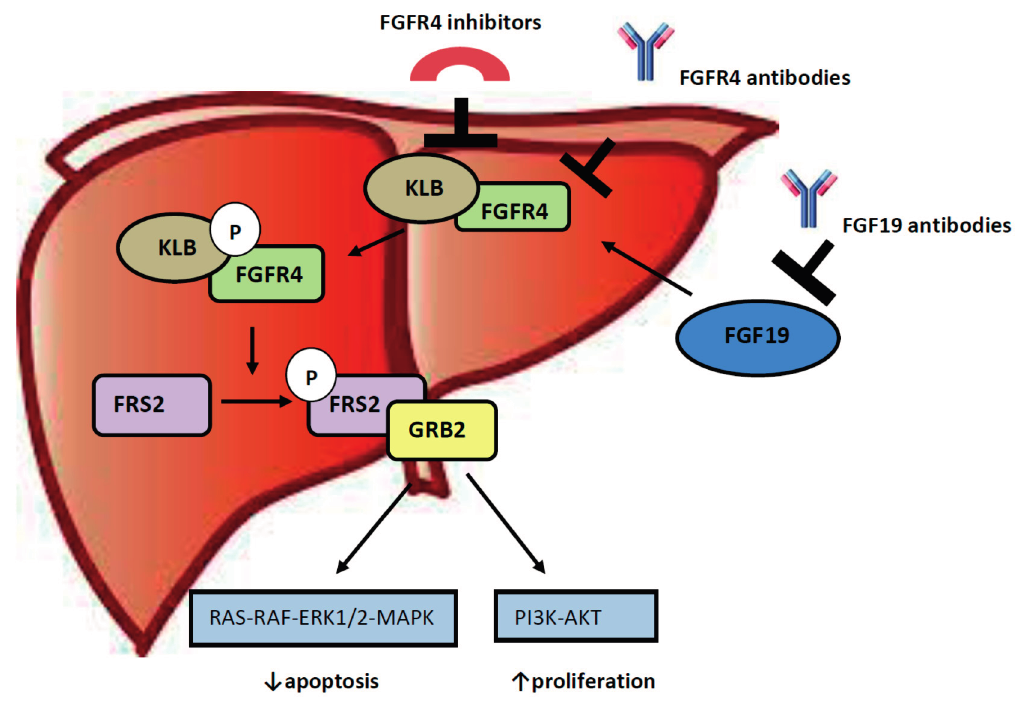
Figure 1. The FGF19/FGFR4 pathway with its main components and targets of inhibitory agents. FGF19: Fibroblast Growth Factor 19, FGFR4: Fibroblast Growth Factor Receptor 4, KLB: Klotho Beta, FRS2: Fibroblast growth factor Receptor Substrate 2, GRB2: Growth factor Receptor-Bound protein